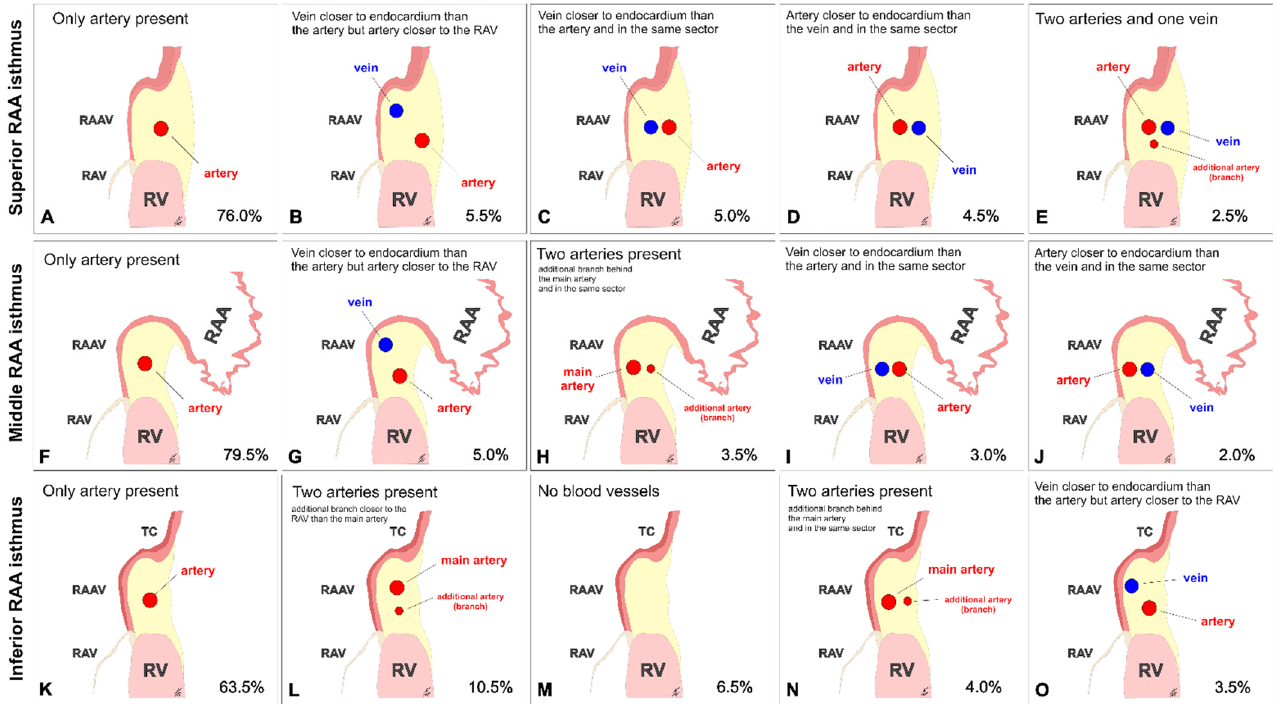
Figure 1. Schematic view of the cross sections thorough right atrial appendage (RAA) isthmuses. Five most common types of spatial relations between coronary vessels within the superior ( A – E ), middle ( F – J ), and inferior ( K – O ) RAA isthmuses are present. RAAV—right atrial appendage vestibule, RAV—right atrio-ventricular valve, RV—right ventricle, TC—terminal crest.